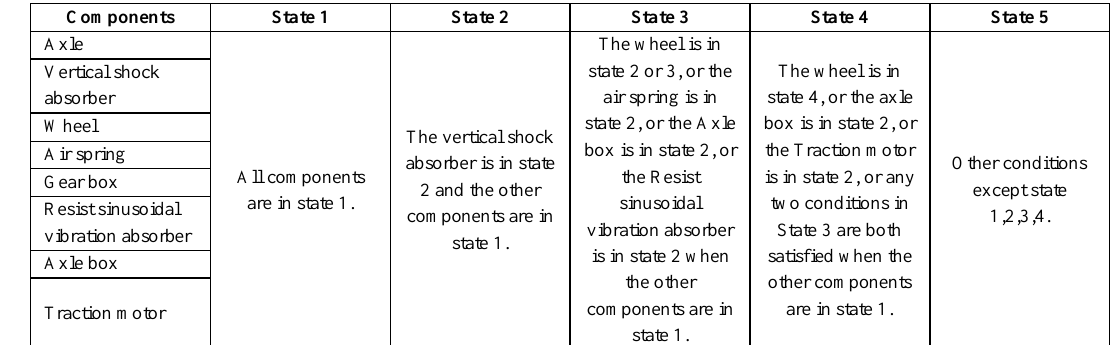
Table 2. Definition of different states of the bogie